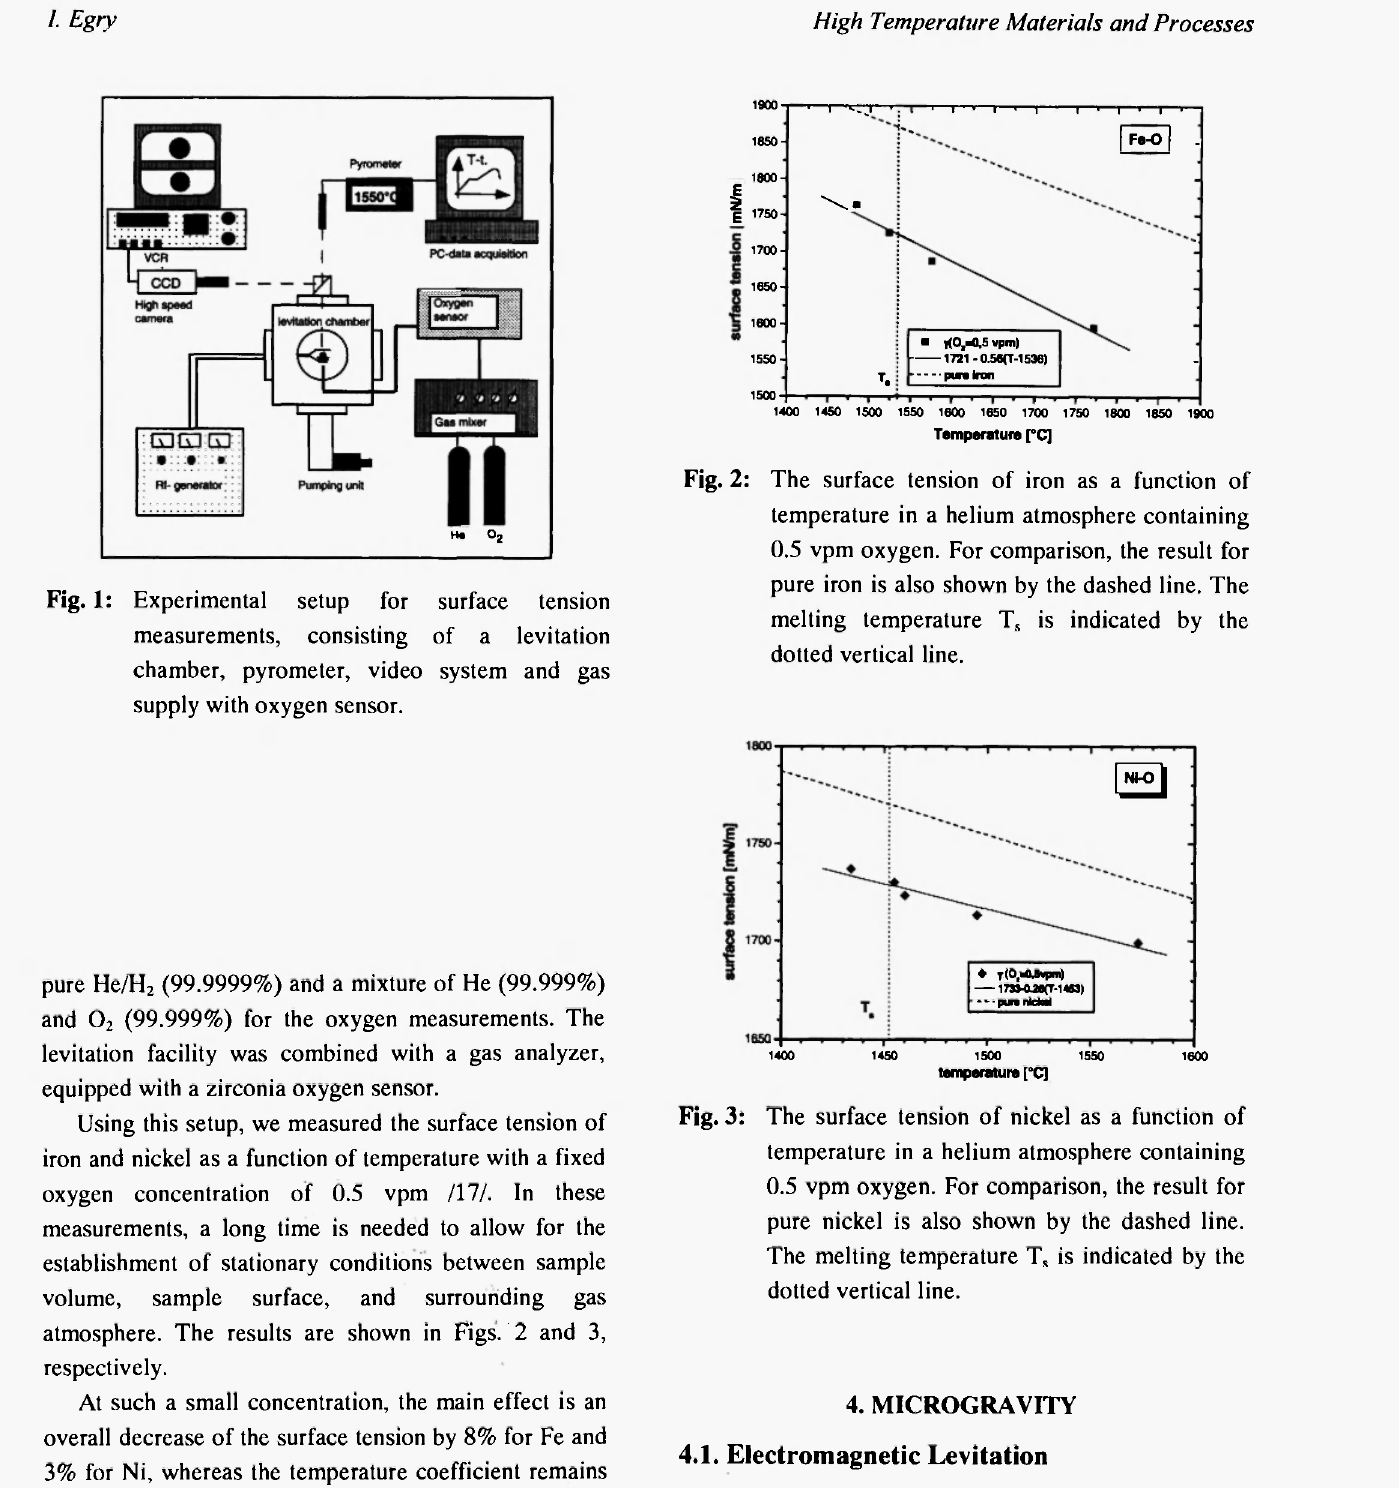
Fig. 1: Experimental setup for surface tension measurements, consisting of a levitation chamber, pyrometer, video system and gas supply with oxygen sensor.